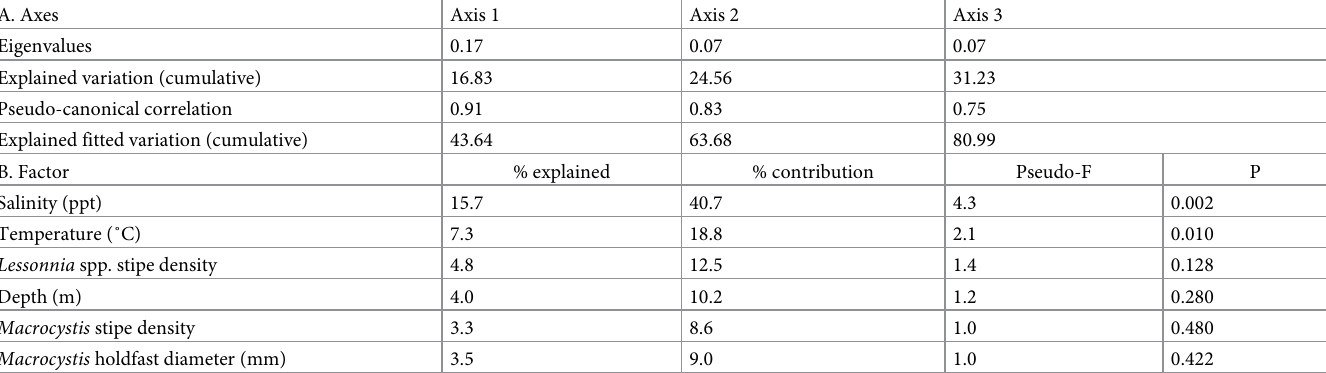
Table 2. Results of redundancy analysis (RDA) on benthic communities. A. RDA on sqrt-transformed benthic community density data with environmental (tempera- ture, depth, salinity) and kelp variables ( Macrocystis stipe density, Lessonia spp. stipe density, Macrocystis holdfast diameter). B. Conditional effects of Monte-Carlo permu- tation results on the